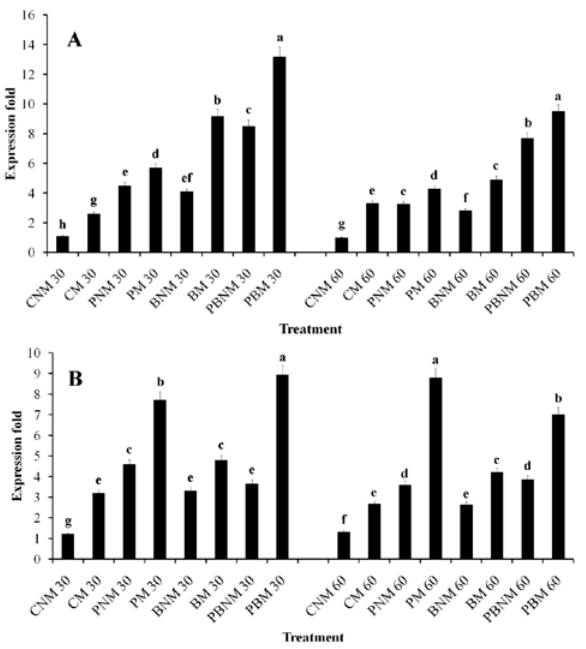
Figure 5. Mean relative transcription expression levels of the defen- sin gene (A) and chitinase gene (B) in garlic plants after different treatments of Sclerotium cepivorum inoculation or AMF and or B. amyloliquefaciens GGA at 30 or 60 dpi. CNM = untreated con- trol, CM = treated with AMF, PNM = inoculated with S. cepivo- rum , PM = inoculated with S. cepivorum and treated with AMF, BNM = treated with B. amyloliquefaciens GGA, BM = treated with B. amyloliquefaciens GGA and AMF, PBNM = inoculated with S. cepivorum and treated with B. amyloliquefaciens GGA, and PBM = inoculated with S. cepivorum and treated with B. amyloliquefaciens GGA and AMF. Each value represents the mean of three biologi- cal replicates, each analyzed in triplicate. Error bars are standard errors. At each growth stage 30 or 60 dpi), means accompanied by the same letter(s) are not significantly different ( P <0.05), Duncan’s multiple range